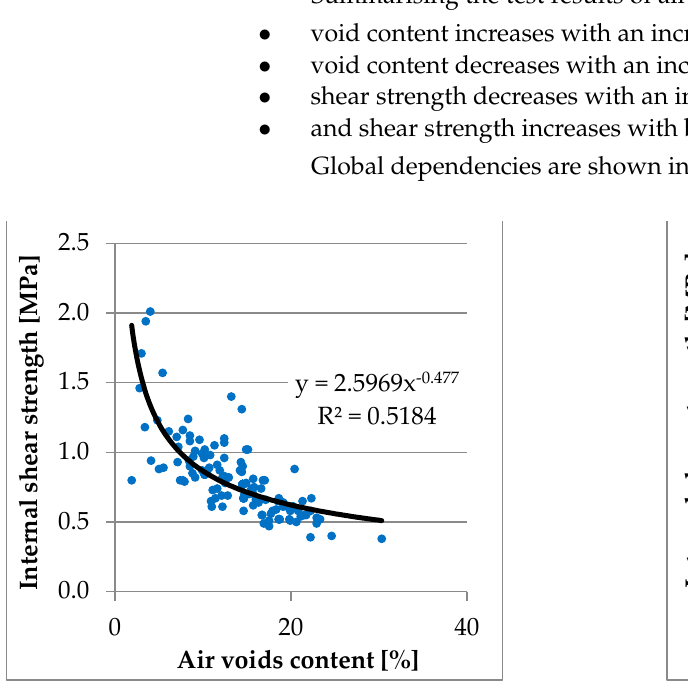
Figure 4. Summary of laboratory test result of internal shear strength versus air voids and rubber content.